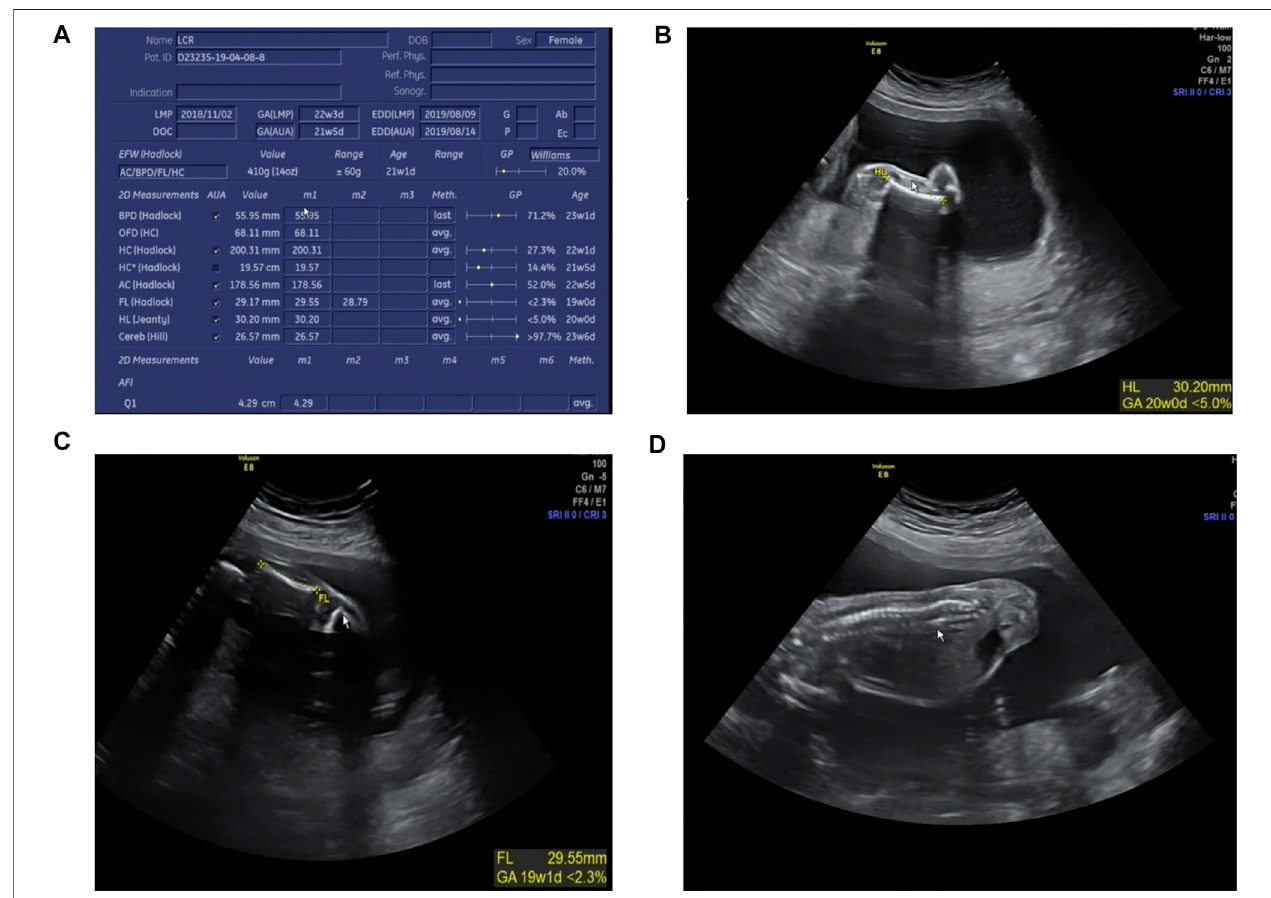
FIGURE5| Radiographicfeaturesofthefetus(at22 +3 weeks ’ gestation). (A) Thefetuswasgenerallysmallerthanthefetusatthesamegestationalage; (B) HLwas equivalent to that of fetus at 20 weeks gestation; (C) FL was equivalent to that of fetus at 19 +1 weeks ’ gestation; (D) Fetus scoliosis could be seen.